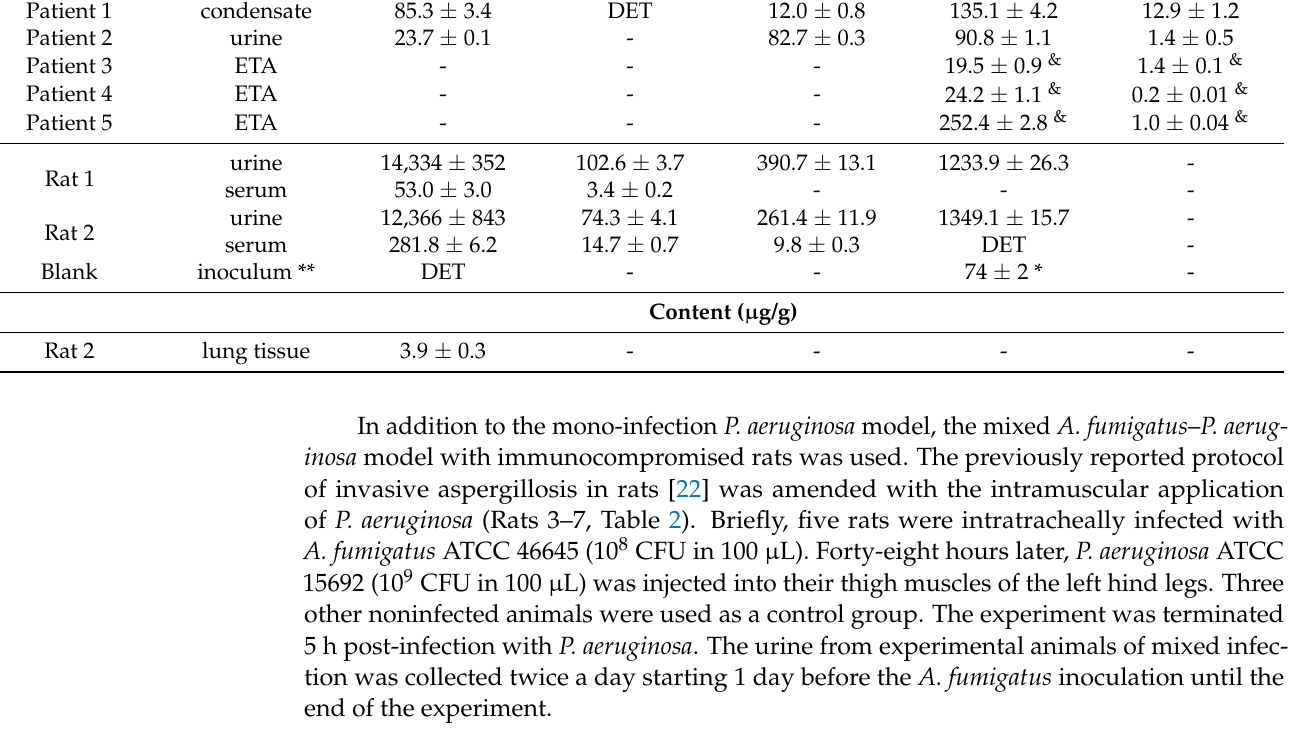
Table 2. Distribution of bacterial (PvdE, Pch) and fungal (Fc, TafC) siderophores reflecting the respective P. aeruginosa and A. fumigatus coinfection. DET, detected (value between LOD and LOQ); -, not detected.